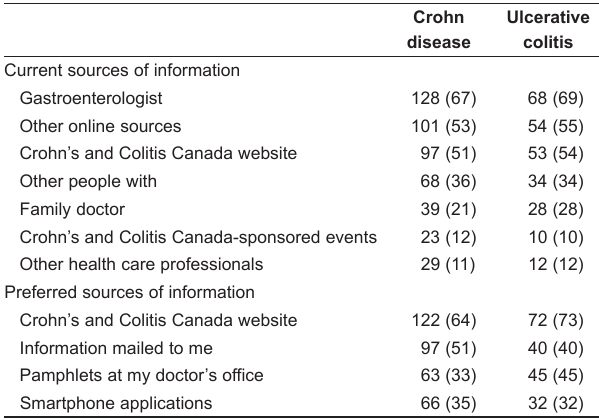
TABLE 3 Current and desired sources of information